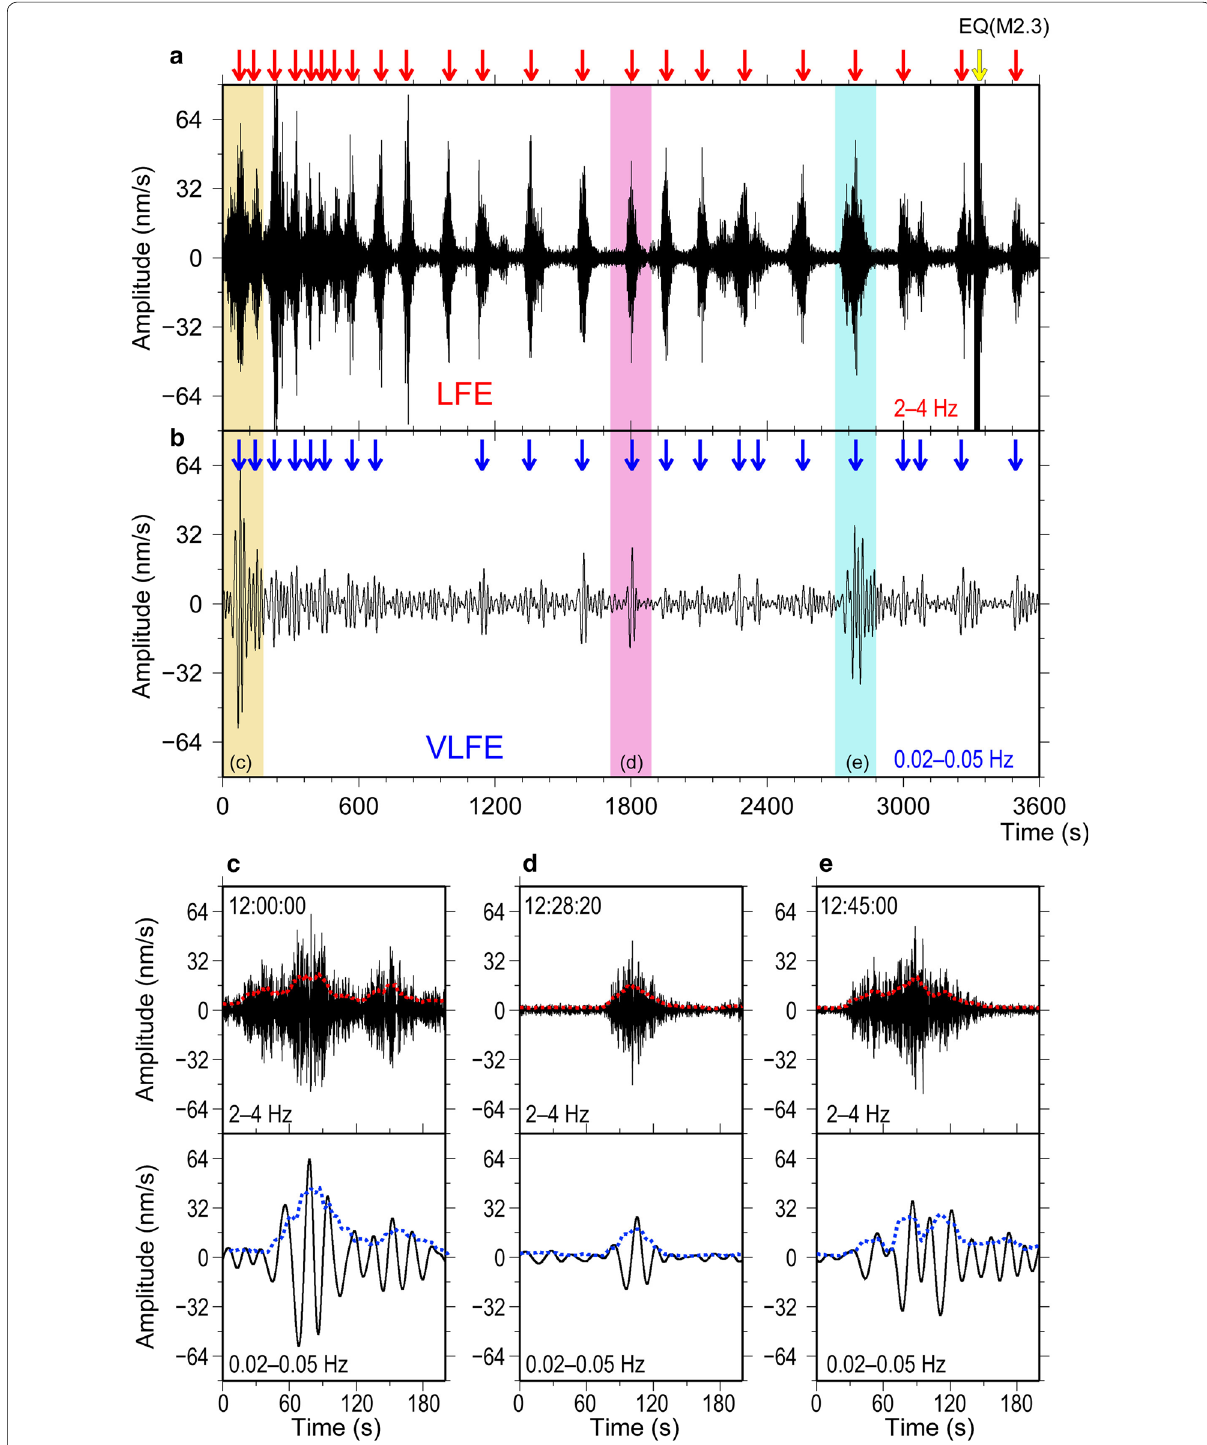
Fig. 2 Example of waveforms at IGK. a 2–4 Hz band-pass-filtered waveform. Data acquired at 12:00–13:00 on June 1, 2005 (UT). Red arrows show the low-frequency earthquakes (LFEs). Yellow arrows show the ordinary earthquakes. b 0.02–0.05 Hz band-pass-filtered waveform. Time range is the same as a . Blue arrows show the very low frequency earthquakes (VLFEs). c Examples for the event at 12:00:00 enlarged from a and b . Upper and lower figures show the waveforms of LFEs and VLFEs, respectively. Red and blue dotted lines show the root-mean-square (RMS) waveforms